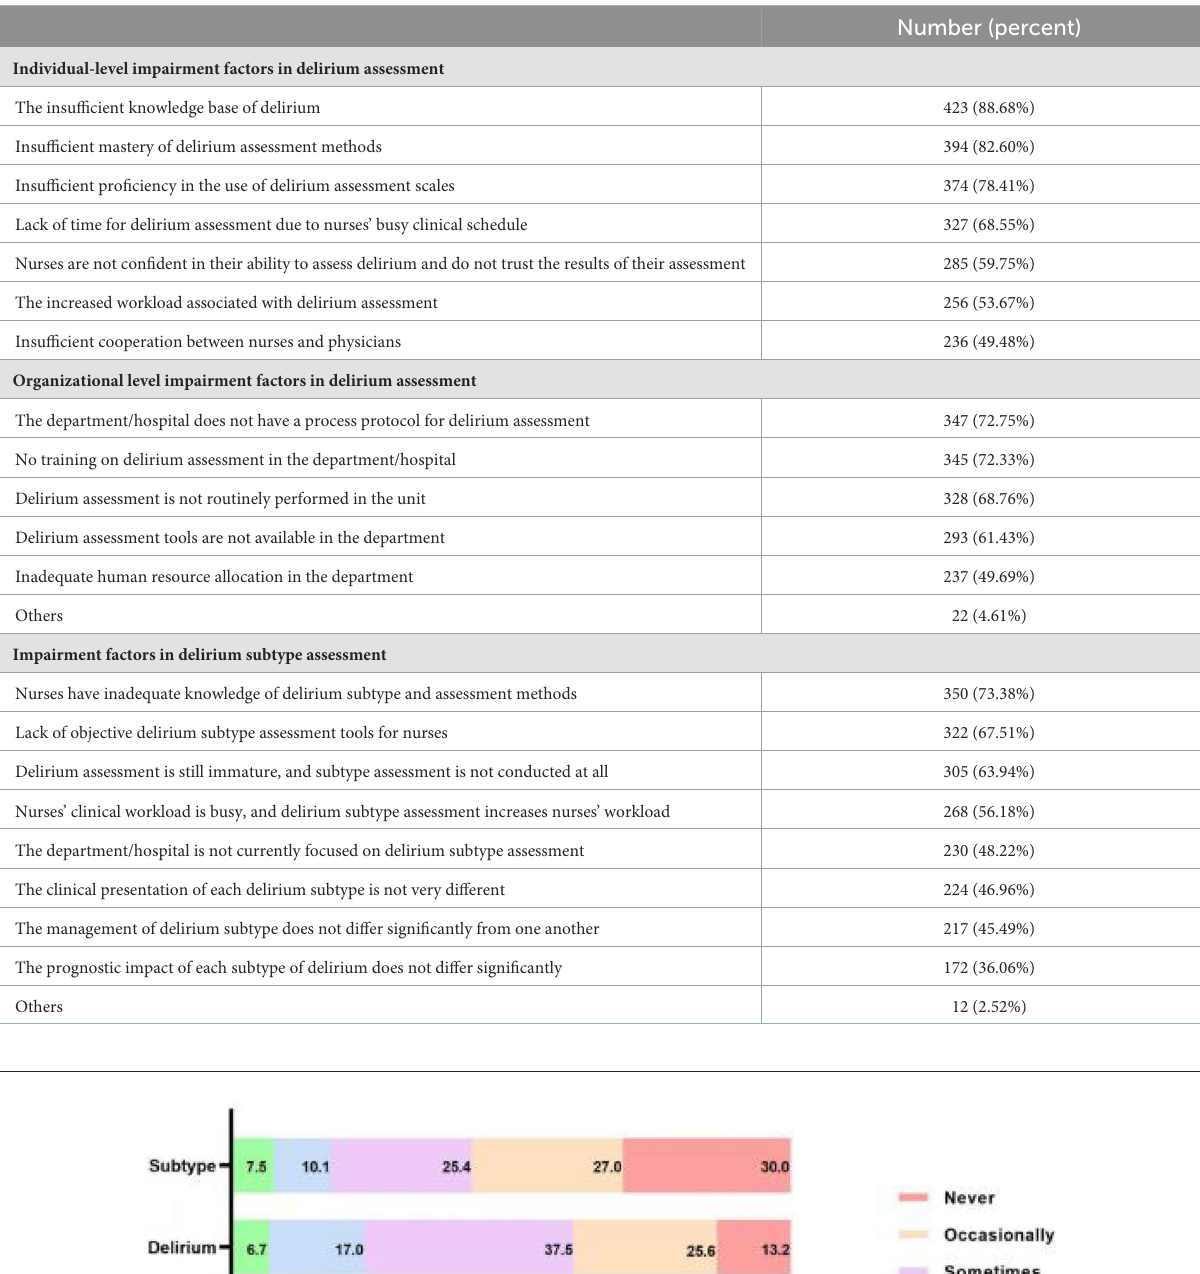
TABLE 3 Barriers of delirium and subtype assessment for clinical nurse ( n = 477).